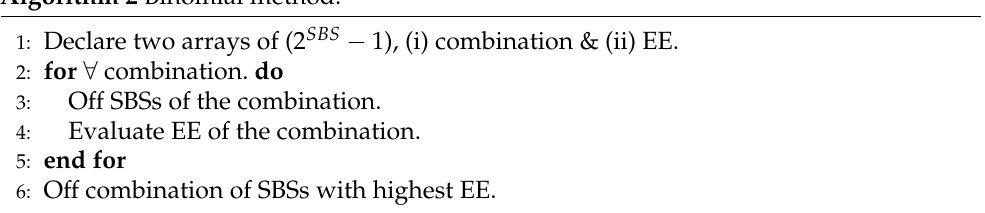
Algorithm 2 Binomial method.